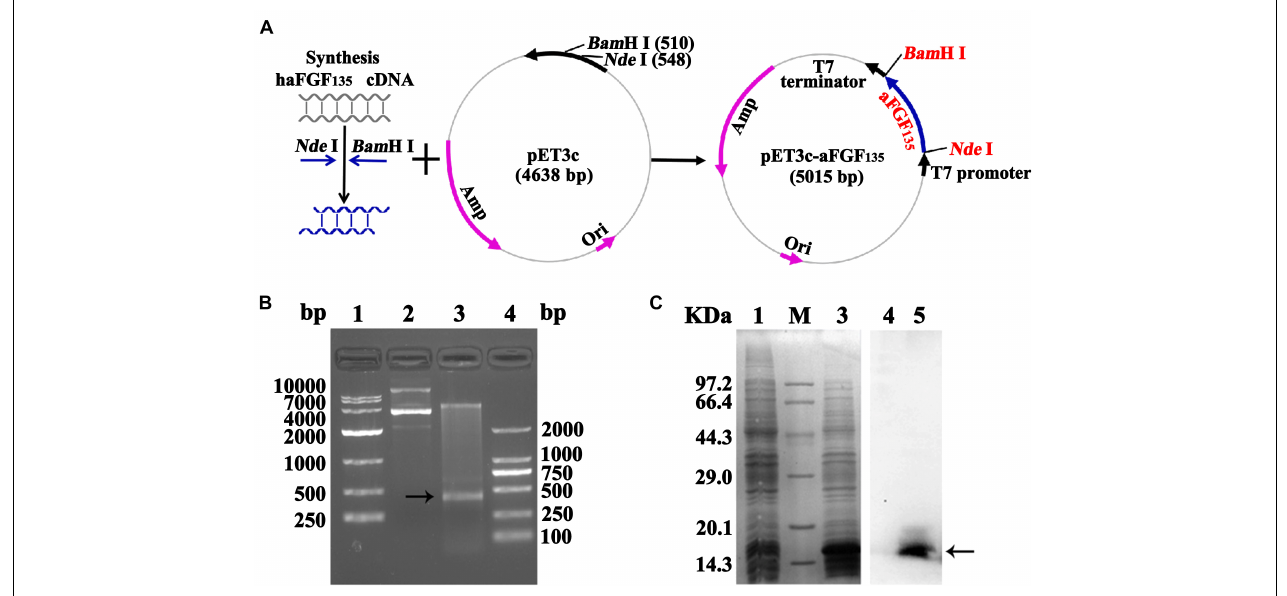
FIGURE 1 | Recombinant plasmid construction and expression of the rhaFGF 135 protein. (A) Schematic diagram of pET3c-rhaFGF 135 recombinant plasmid construction. (B) Restriction enzyme analysis of the pET3c-rhaFGF 135 recombinant plasmid. Lanes 1 and 4, DNA molecular weight marker. Lane 2, plasmid before digestion. Lane 3, plasmid after digestion. (C) SDS-PAGE (left) and western blot (right) analyses of the expressed rhaFGF 135 protein in the lysis of E. coli BL21(DE3) plysS. Lanes 1 and 4, non-induced. Lanes 3 and 5, induced by IPTG for 4 h. Lane M, molecular weight marker. Black arrows indicate rhaFGF 135